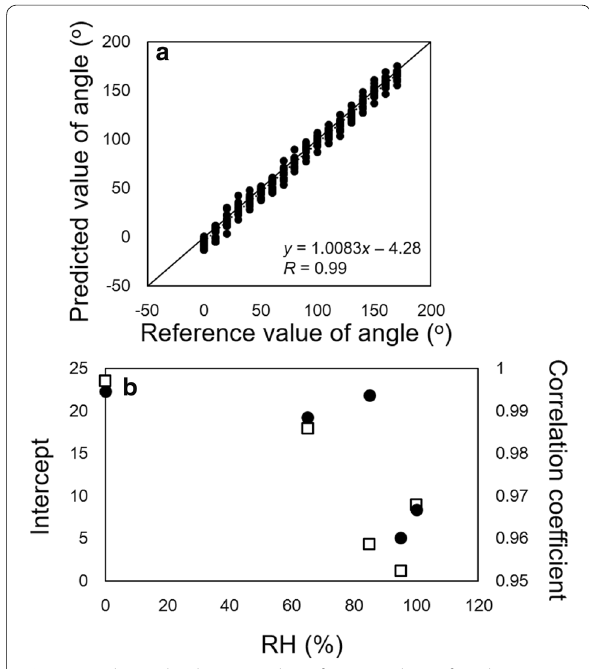
Fig. 4 a Relationship between the reference values of angle between fiber direction and THz orientation, and predicted value from THz signal (RH 85%). b Relation between relative humidity and = intercept (opened square) and correlation coefficient (closed circle) of regression line between reference values of angle between fiber direction and THz